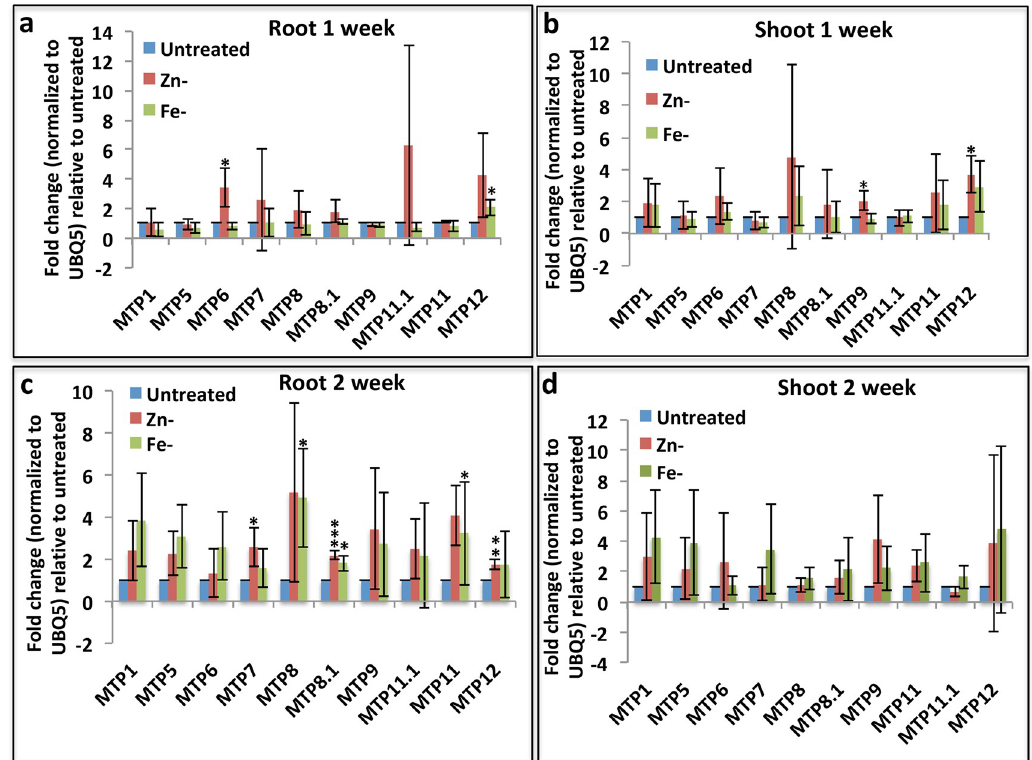
Fig 6. Gene expression changes of rice MTP genes in response to starvation conditions of Zn and Fe. Q-PCR analysis of MTP genes in roots (a, c) and shoots (b, d) in response to 1 week (a, b) or 2 week (c, d) of Zn or Fe deficiency conditions. The fold change is calculated against untreated samples. Asterisks indicate T-test results where � = p < 0.05, �� = p < 0.01, ��� = p < 0.001.